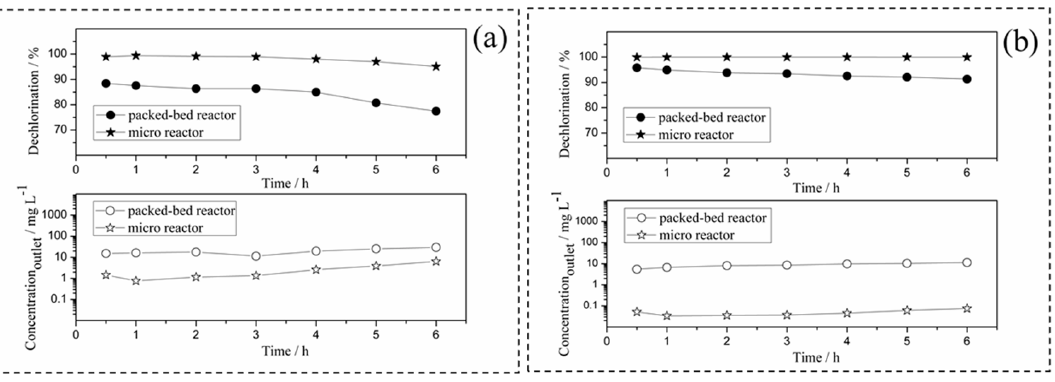
Figure 3. Hydrodechlorination (HDC) performance under 2:1 formic acid (FA)/substrate molar ratio ( a ) and 5:1 FA/substrate molar ratio ( b ) in different continuous flow reactors. Reaction conditions: residence time (3 min), Pd loading (0.5 wt.%), 4-chlorophenol concentration (1 mmol/L).